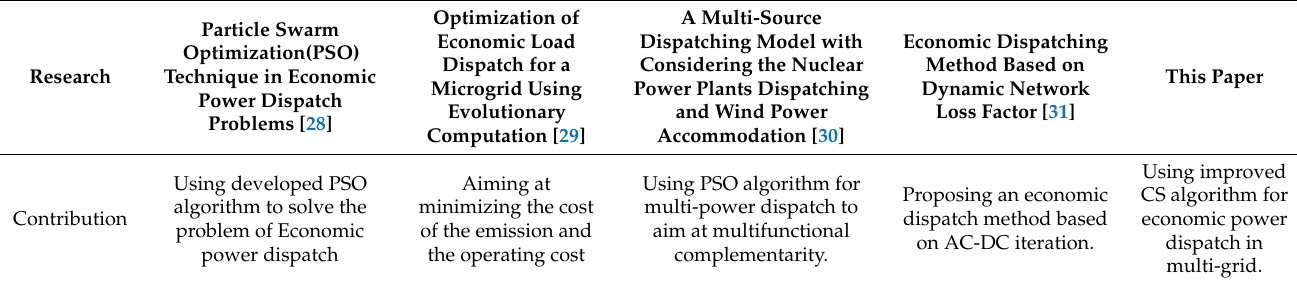
Table 1. Comparing of the milestones.